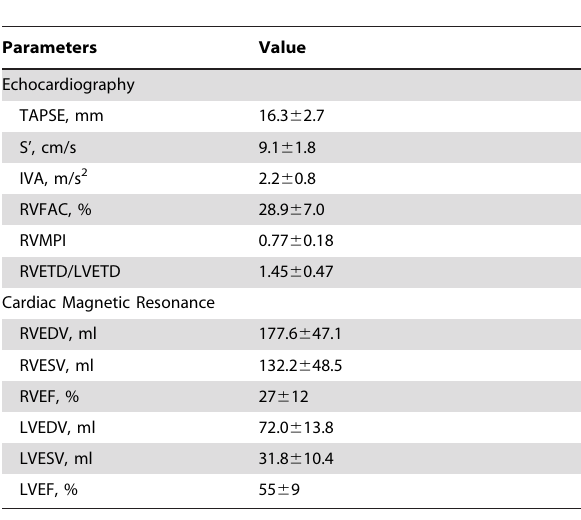
Table 3. Correlations between echocardiographic parameters and